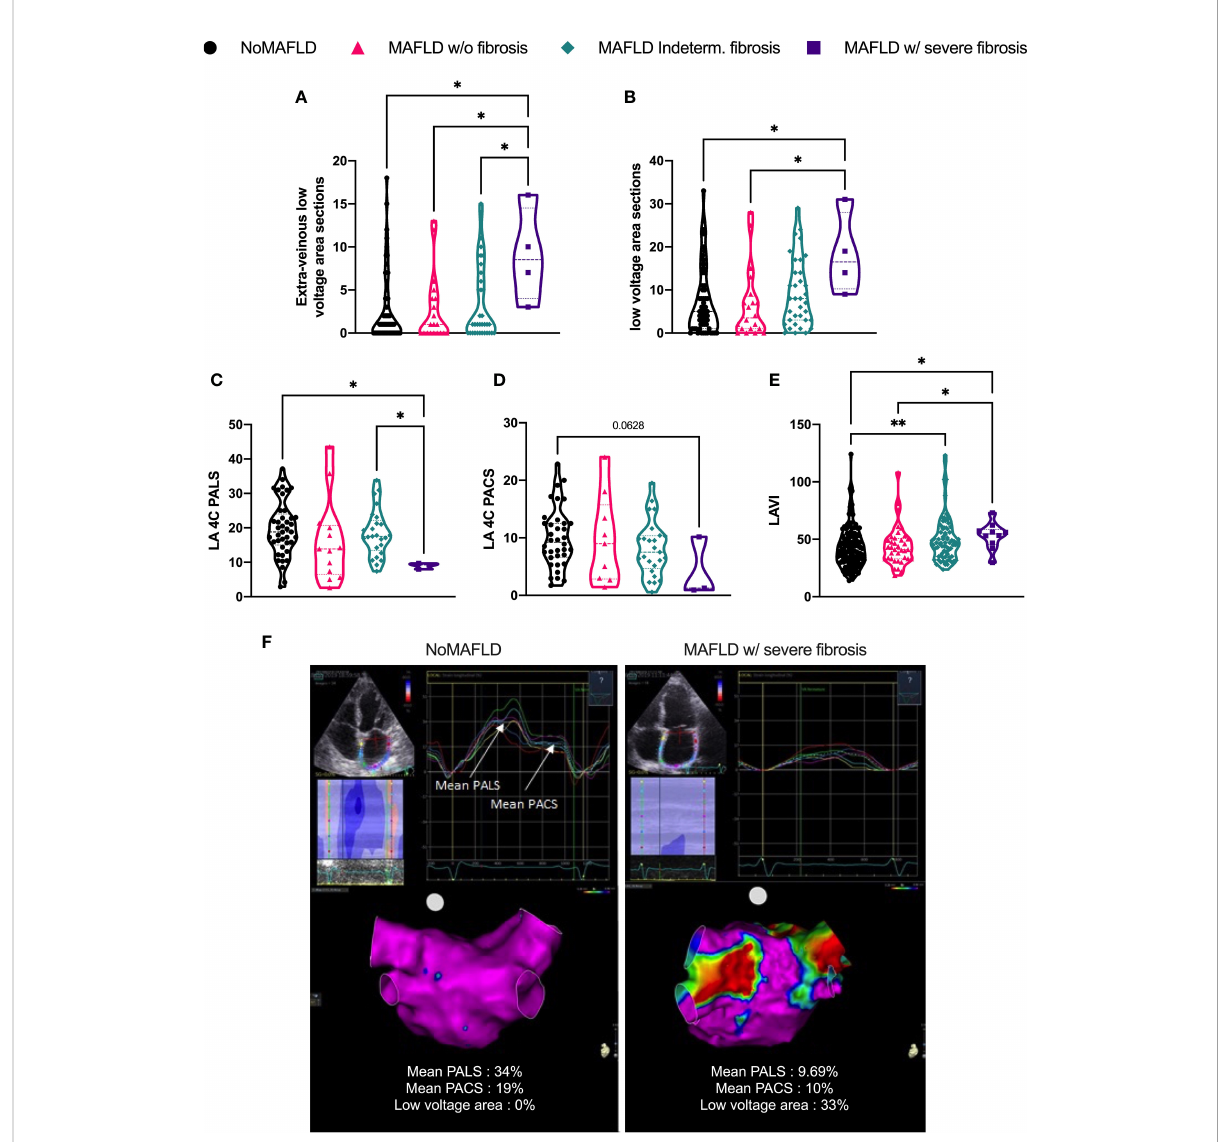
FIGURE 1 Left atrial structural and electrical remodeling parameters. Number of low-voltage area extra-venous (A) or total (B) ; peak atrial longitudinal strain (C) and peak atrial contraction strain (D) ; left atrial volume indexed to body surface area (E) . Representative echography, strain values, and bipolar voltage maps (low-voltage cutoff: 0.5 mV) (F) . NoMAFLD: FLI < 60; MAFLD w/o fi brosis: FLI > 60 and NFS < 1.455; MAFLD ind. fi brosis: FLI > 60 and − 1.455 < NFS < 0.675; MAFLD w/severe fi brosis: FLI > 60 and NFS > 0.675. Kruskal – Wallis test followed by Dunn ’ s post-hoc test. *p < 0.05; **p < 0.01. MAFLD, metabolic dysfunction-associated fatty liver disease; LA, left atria; PALS, peak atrial longitudinal strain; PACS, peak atrial contraction strain; LAVI, left atrial volume